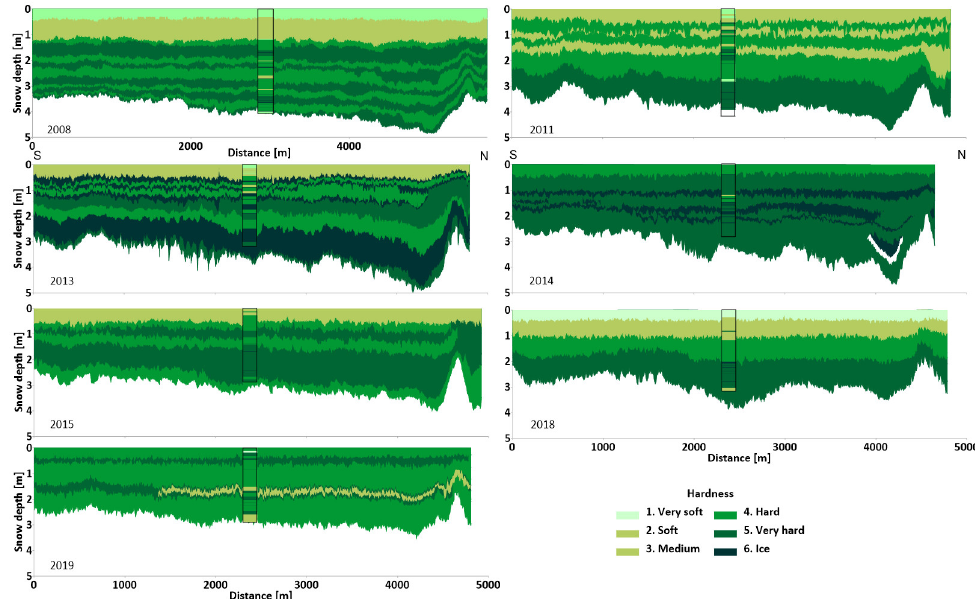
Figure 7. Hardness index. Vertical rectangles in the middle of the GPR profiles denote HS and the hardness index in the snow pits (H9). The white spaces represent undefined hardness. See the location of the GPR profiles on Figure 1.